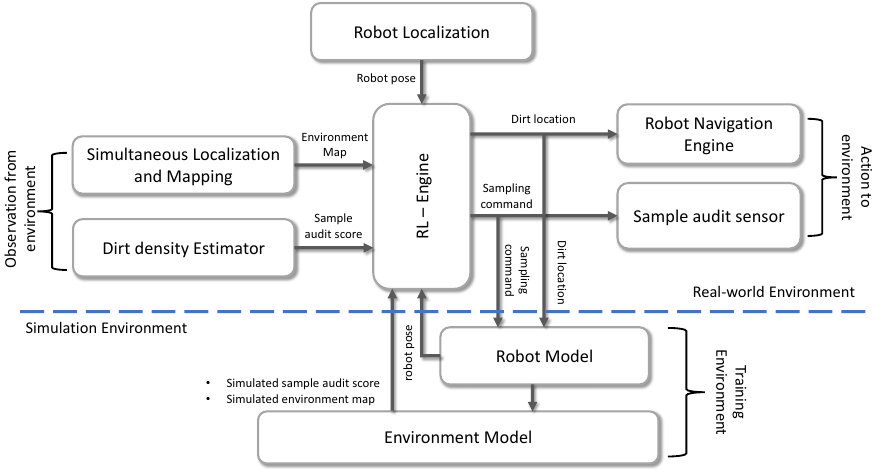
Figure 2. The overview of RL based dirt exploration strategy for autonomous cleaning- auditing